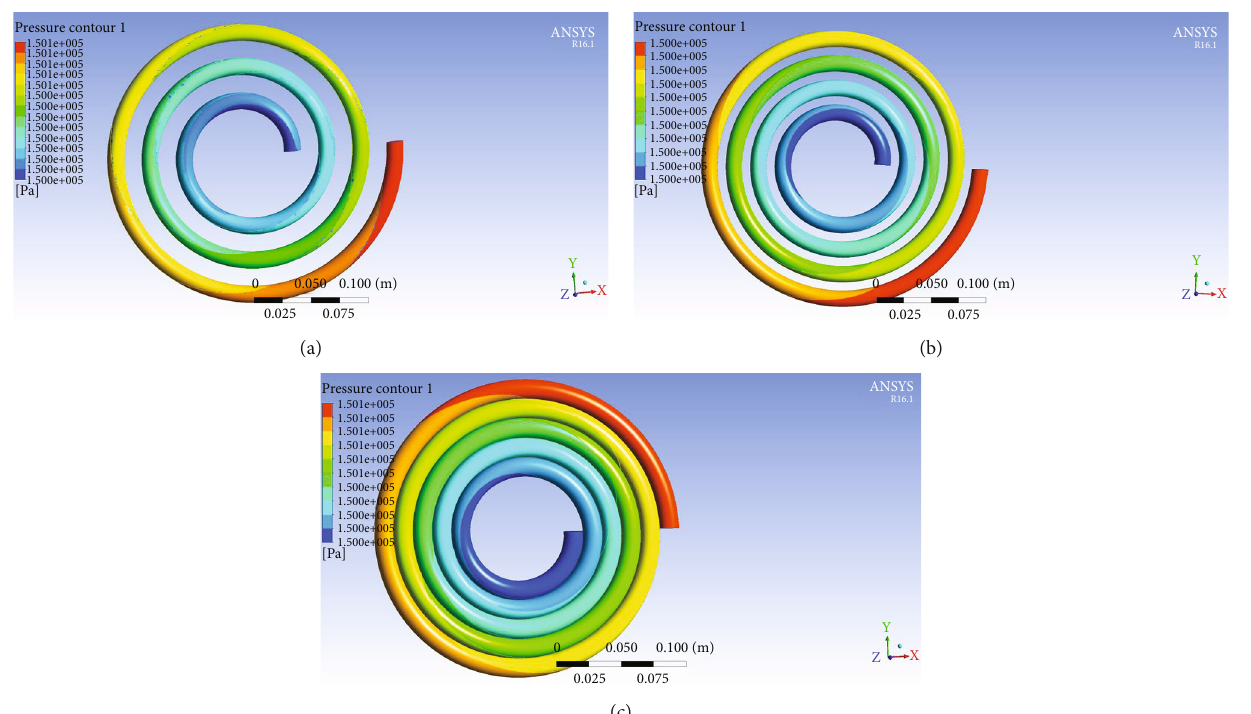
Figure 4: Pressure contours for coil of (a) three convolutions, (b) four convolutions, and (c) fi ve convolutions.